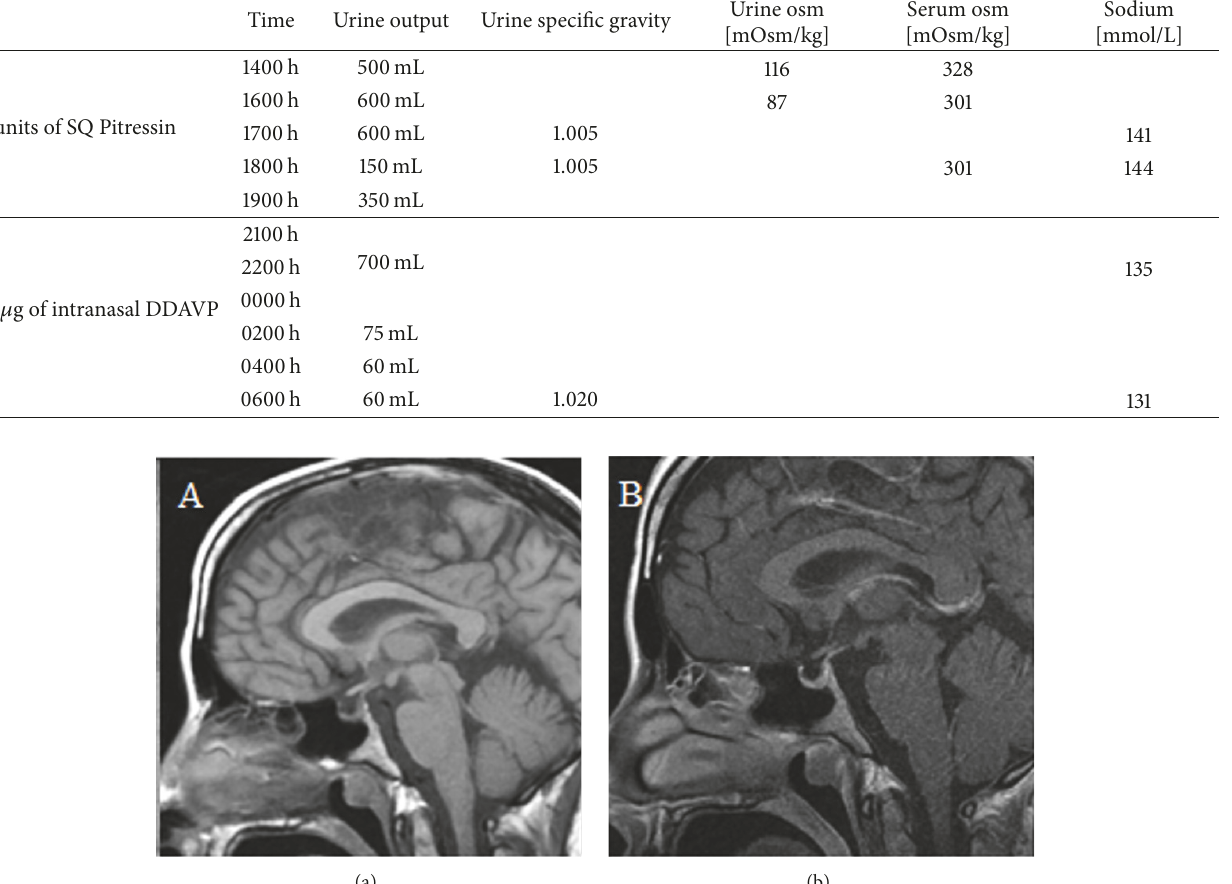
Table 2: Pitressin and DDAVP challenge for Case 1 .